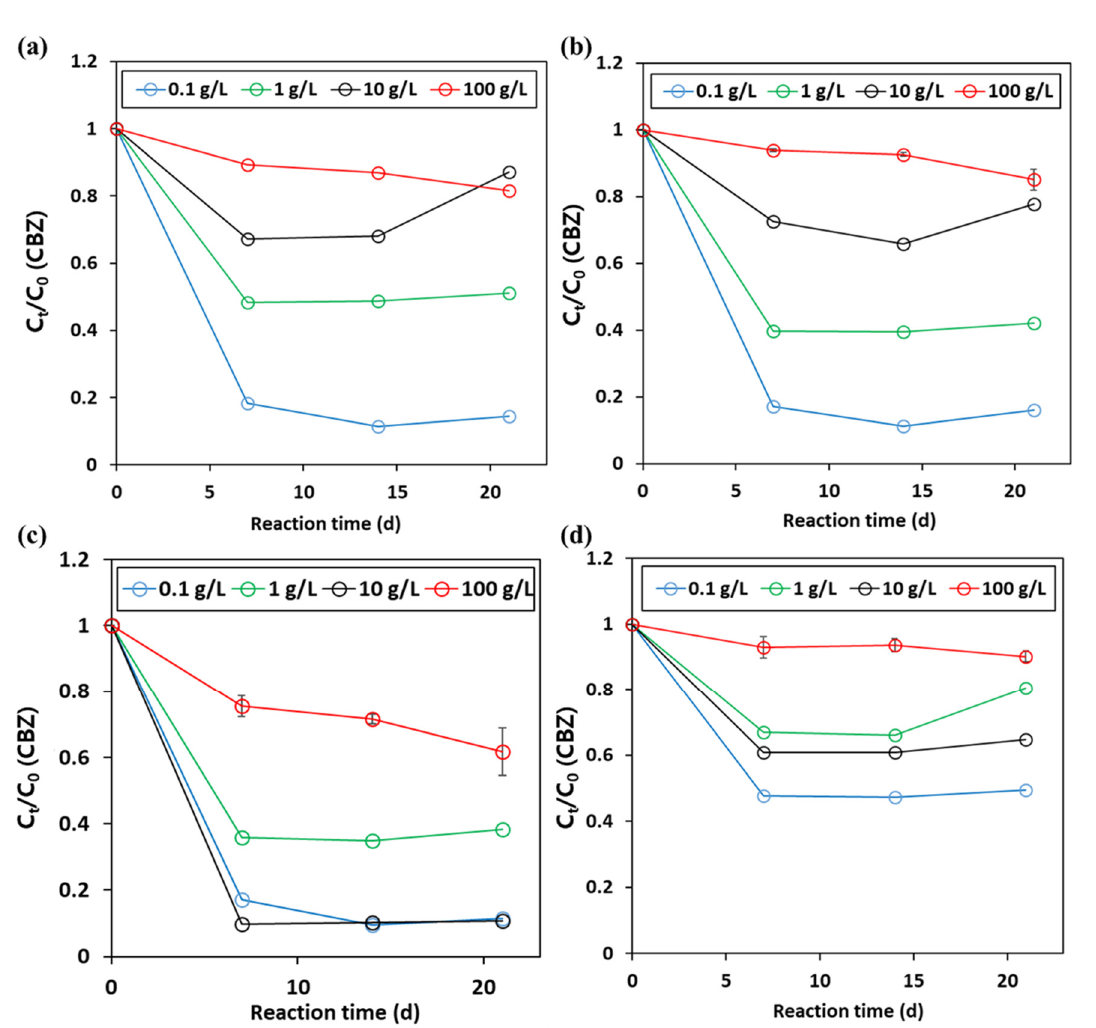
Figure 1. The effects of the concentration of metal oxides on carbamazepine (CBZ) degradation by peroxymonosulfate (PMS) oxidant ( a ) Fe 2 O 3 –PMS treatment, ( b ) Fe 3 O 4 –PMS, ( c ) FeOOH–PMS, and ( d ) MnO 2 –PMS ([CBZ] = 10 µM, [PMS] = 200 µM, [borate buffer] = 18.75 mM, [pH] = 7.5~8.0, sampling time = 0, 7, 14, and 21 d).